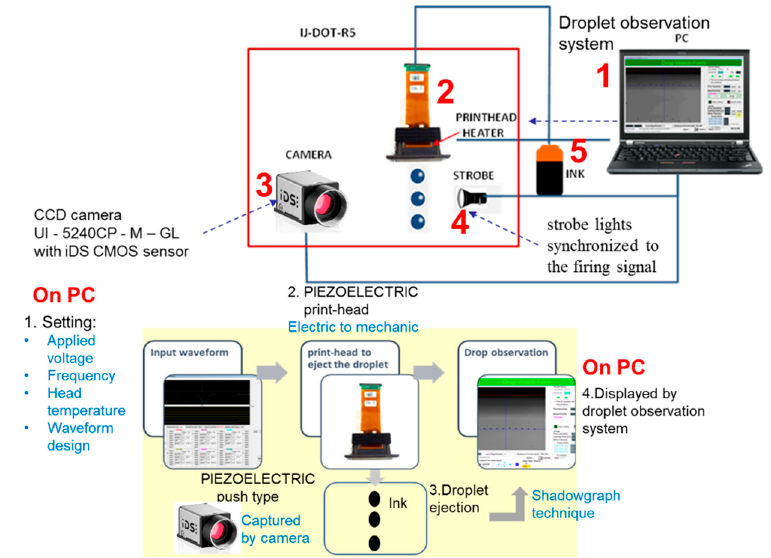
Figure 3. The experimental scheme.